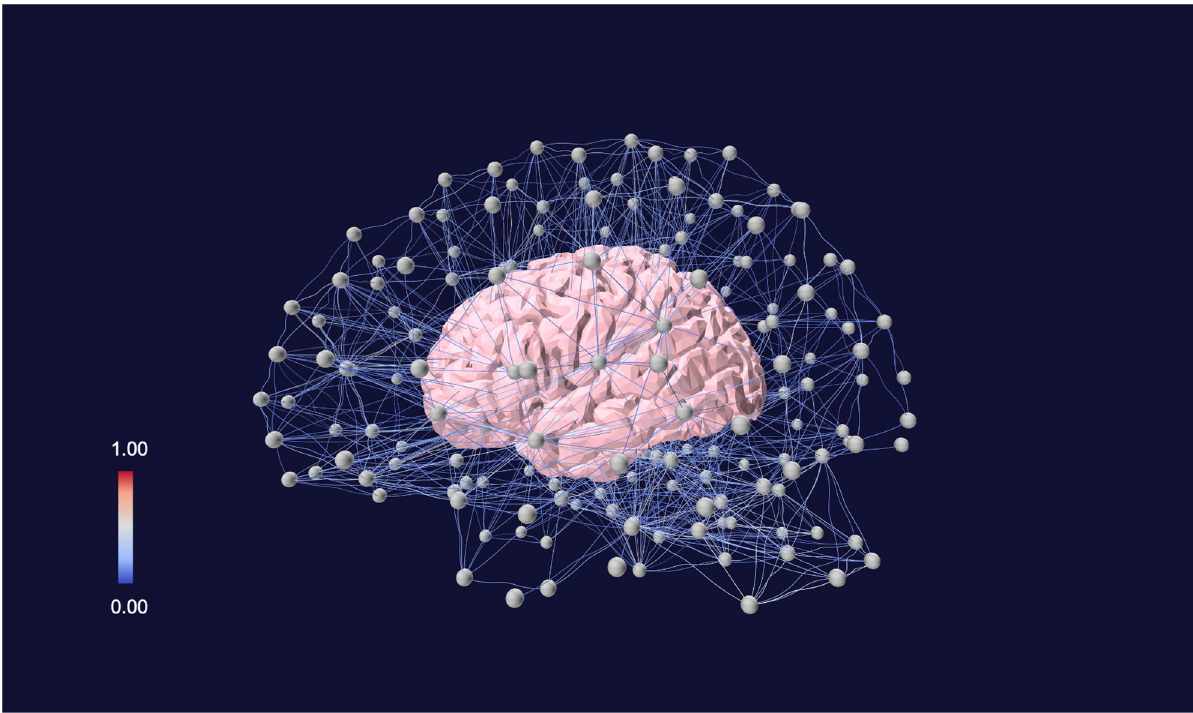
Fig 8. Structural brain connectivity. Nodes represent brain regions of interest, links represent anatomical connections between nodes. In particular, the color of the links indicates the probability to find anatomical fiber bundles between different brain areas. Data available from [14]. The network has been visualized with Vizaj using a Bell shape for the links.